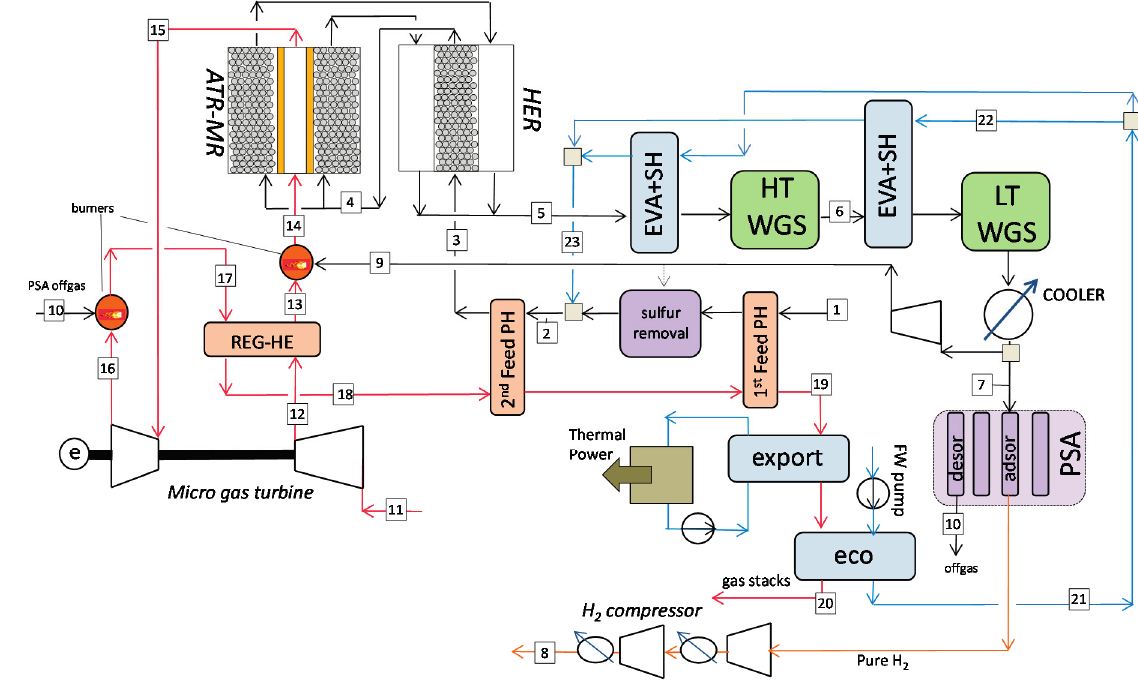
Figure 4. Plant design of the auto-thermal process with MIEC membranes for small-scale H 2